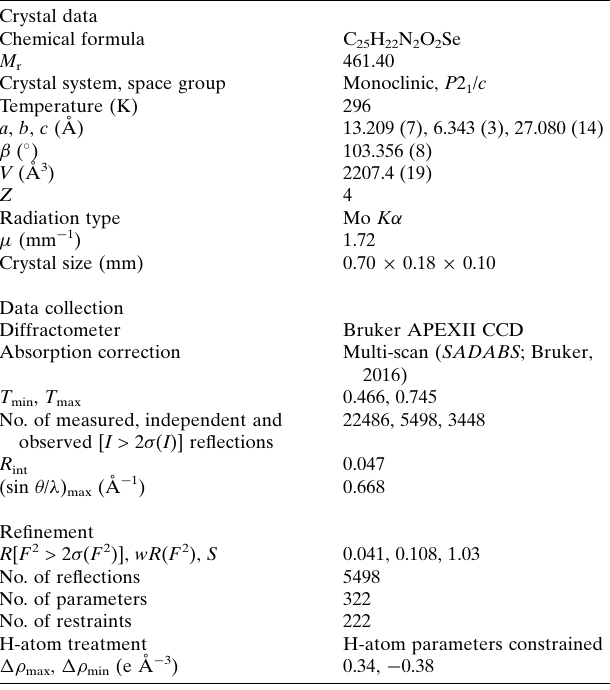
Table 1 Experimental details. Crystal data Chemical formula